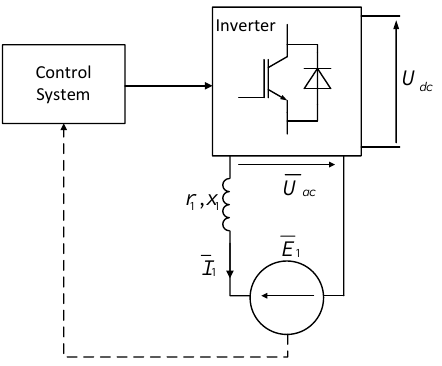
Figure 3. Equivalent diagram of the propulsion system with PMSM.